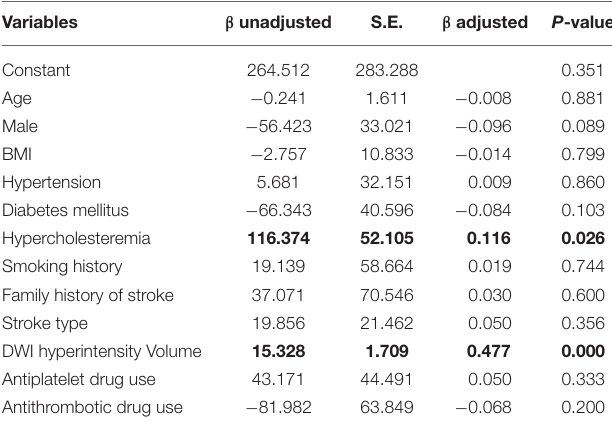
TABLE 2 | A linear regression model to investigate potential factors associated with plasma sCD163 levels.